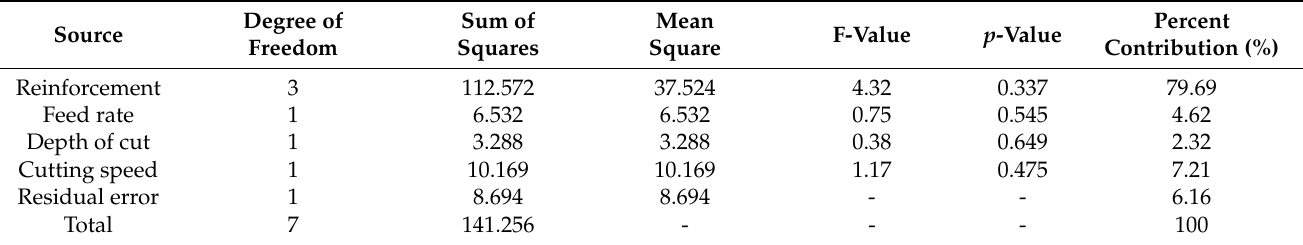
Table 6. Analysis of variance for S/N ratios of cutting temperature.